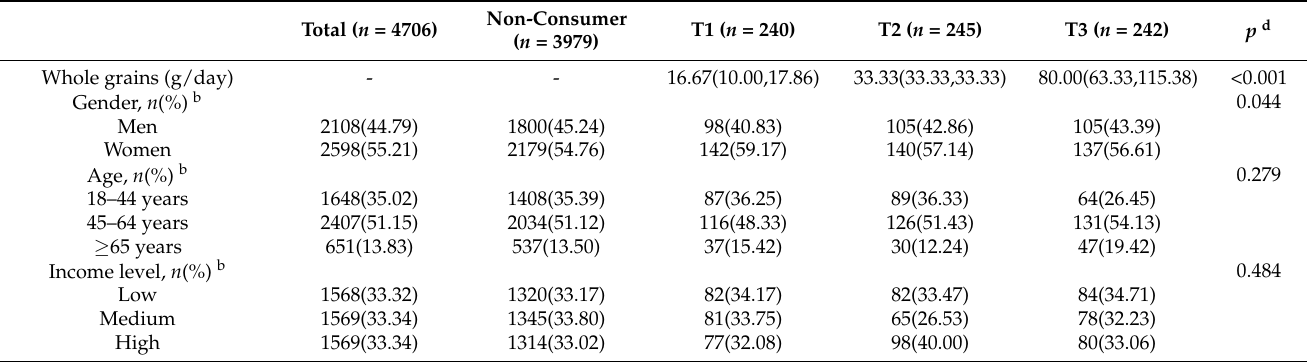
Table 1. Baseline characteristics of participants across the levels of whole grain intake in 2011,